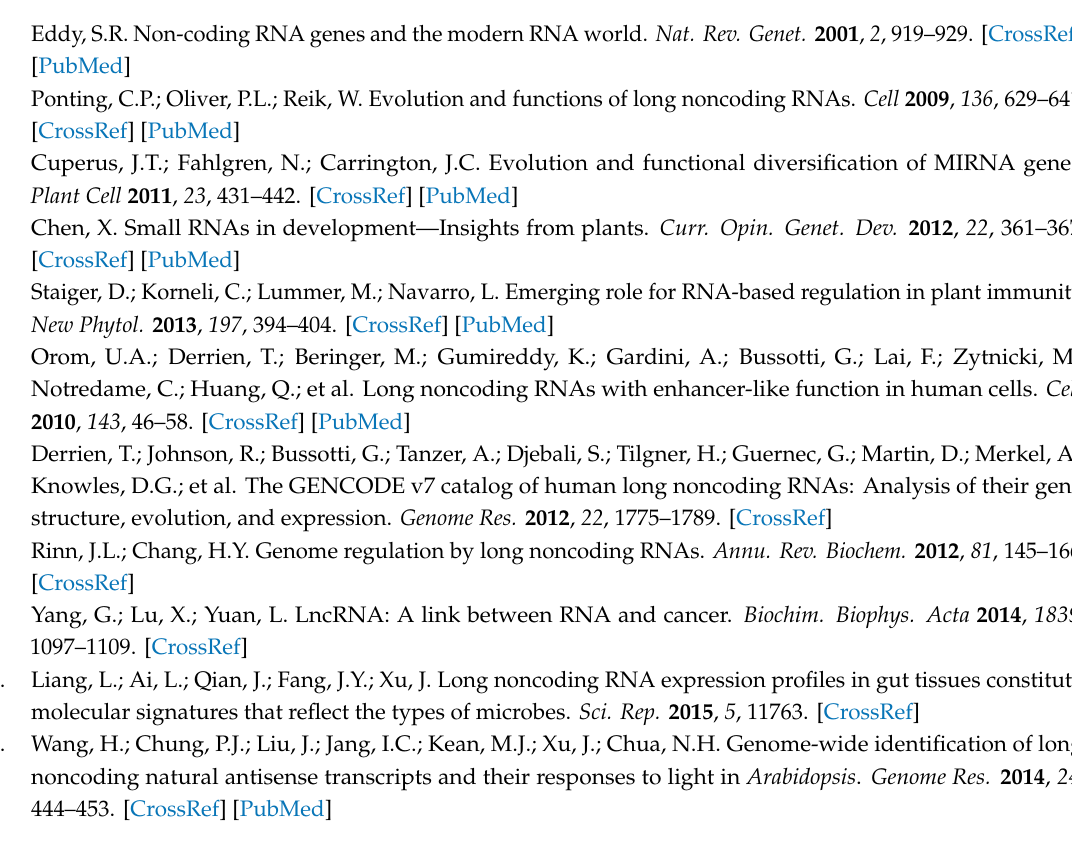
Figure S1: Characteristics of peanut mRNA. (a) Number of exon of mRNA. (b) Expression level of mRNA and lncRNA, Figure S2: Correlation of module memberships versus lncRNA significance for tissues. Scatterplot graphs show the correlation of module memberships of the lncRNAs in modules versus significance of the lncRNAs for the tissues, Figure S3: Expression profile. Heatmaps show the expression profile of all the co-expressed genes in turquoise, pink, and red modules. Red represents up-regulated lncRNAs and green represents down-regulated lncRNAs. The consensus expression pattern of the co-expressed lncRNAs in modules was shown by bar graphs (below the heat maps), Figure S4: Number of hub lncRNA in di ff erent modules. (a) The bar graphs show the number of hub genes in these nine modules. (b) The bar graphs show the number of known (red) and unknown (blue) target genes, Table S1: Overview of 124 samples, Table S2: Characteristics of mRNAs and all putative lncRNAs, Table S3: Number of samples in each tissue, Table S4: Functional analysis of target genes of hub lncRNA in di ff erence